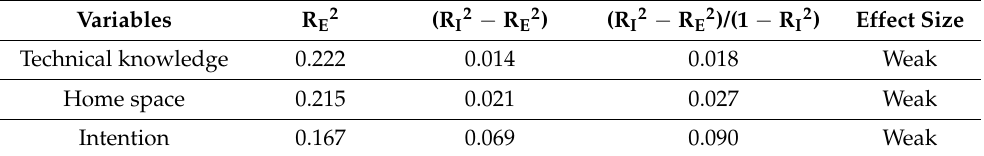
Table 7. Effect Size in Behavior